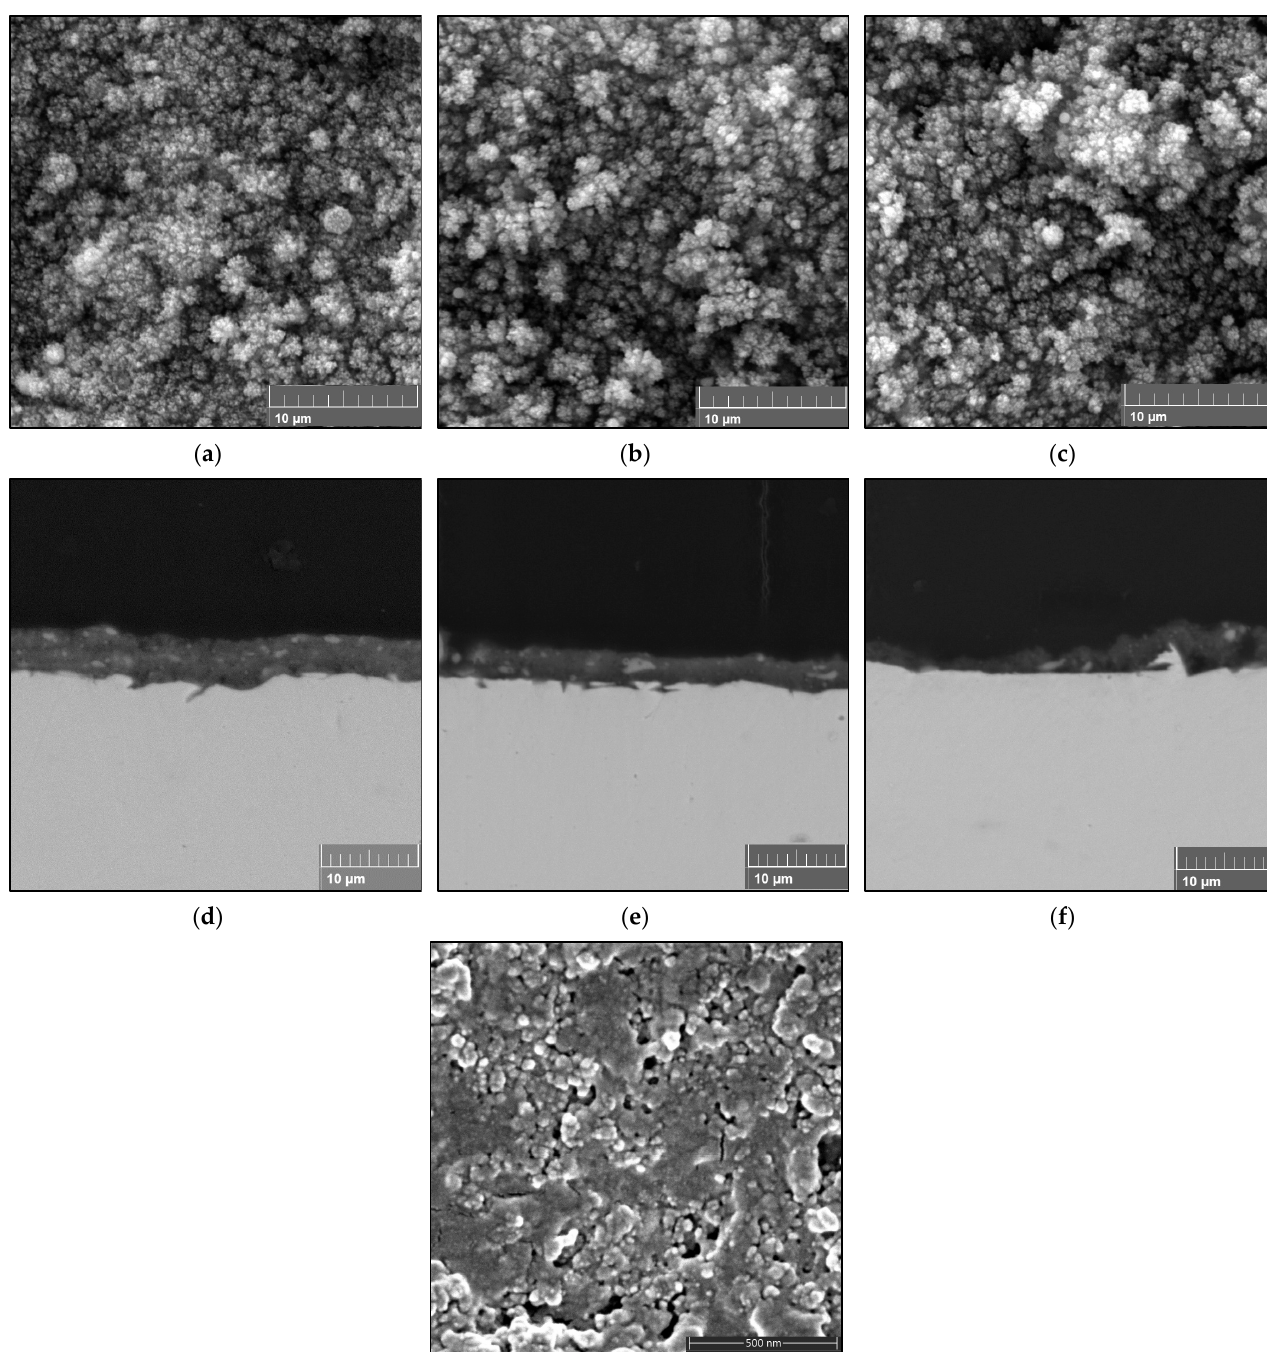
Figure 5. SEM micrographs of the surface of coatings obtained from full-pass sprayed (0.6 M) TiO 2 solution and their cross-sections at ( a , d ) 40 mm, ( b , e ) 50 mm, and ( c , f ) 60 mm stand-off distances. ( g ) The cross-sectional coating structure of FS2SD40 .